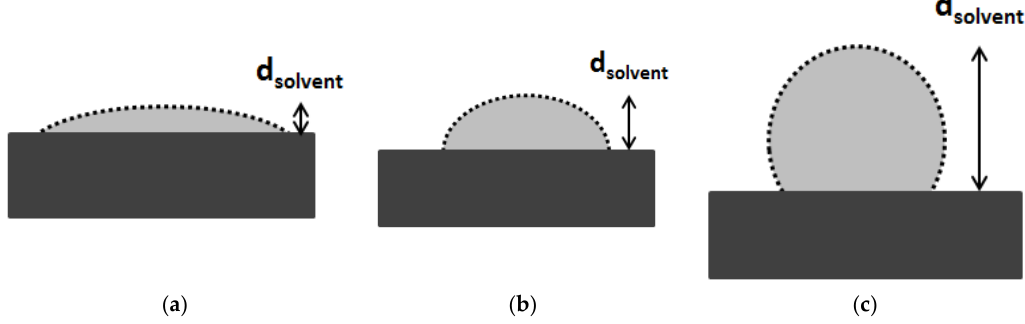
Figure 1. Schematic representation of SRNF membrane, dimension of parameters and membrane.